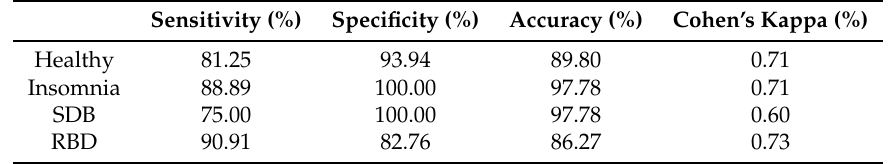
Table 9. Evaluation performance of each sleep disorder subjects and non-patients (healthy subjects).